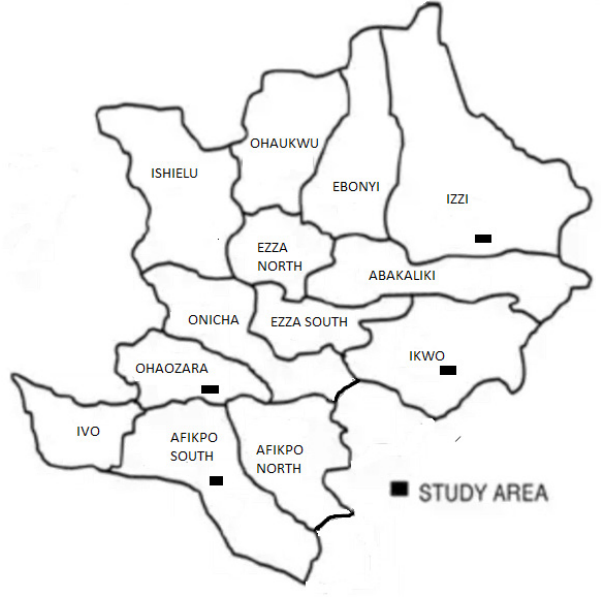
Figure 1 : Map of Ebonyi State showing location of study